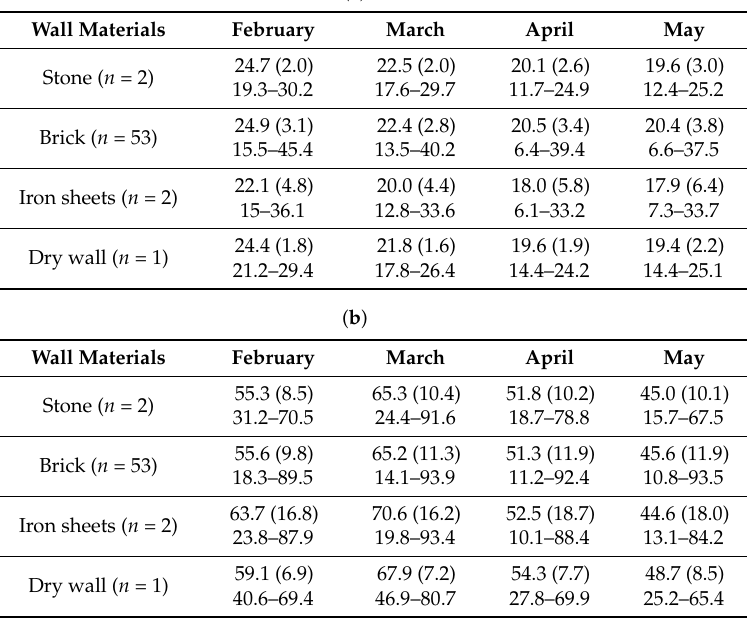
Table 7. ( a ) Monthly indoor temperatures (in ◦ C) by wall material (means and standard deviations, ranges below); ( b ) Monthly indoor humidity (%) by wall material (means and standard deviations, ranges